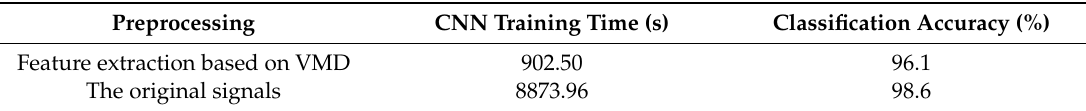
Table 3. Comparison between VMD feature extraction and the original signals.